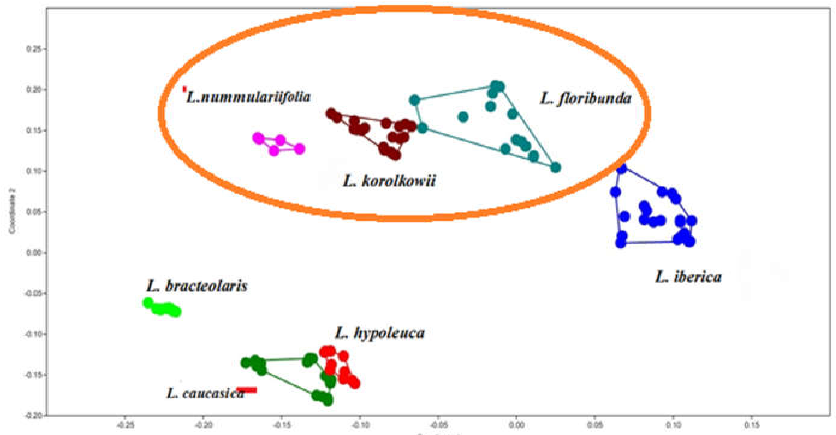
Fig. 2 . PCOA plot of morphological characters revealing species delimitation in Lonicera.